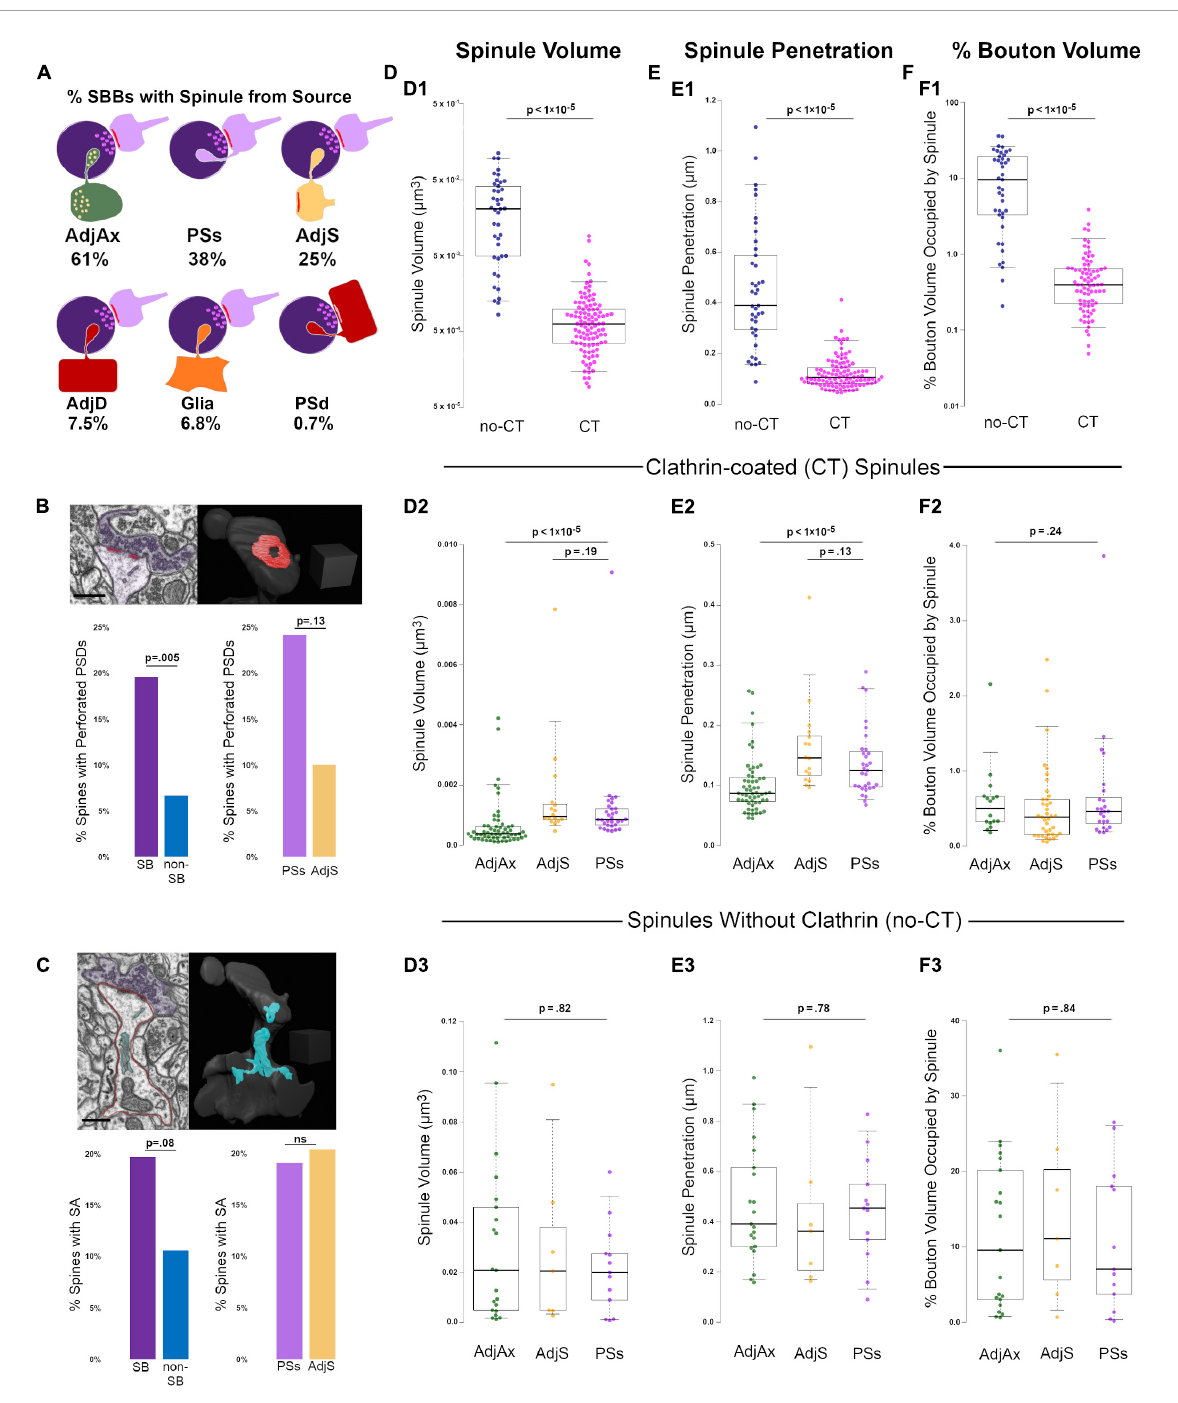
FIGURE2 Clathrin-coated (CT) and uncoated spinules (no-CT) are distinct populations within CA1 SBBs. (A) Cartoon showing the percentage of SBBs containing at least one spinule from adjacent axons/boutons (AdjAx), postsynaptic spines (PSs), adjacent (no synapse with SBB) spines (AdjS), adjacent dendrites (AdjD), glia, and postsynaptic dendrites (PSd). Percentages reflect the ∼ 42% of SBBs with spinules from multiple sources. (B) Percentage of perforated PSDs in postsynaptic spines in this image volume. Upper left panel shows a FIB-SEM image of a postsynaptic spine (pink) with a perforated PSD (red) and its presynaptic SBB partner (purple). Note the CT spinule projecting just to the right of the PSD. Upper right panel shows 3D reconstruction of spine and PSD from FIB-SEM image; note this is the same spine as shown in Figures 1G 2 ,G 3 . Lower left panel shows the percentages of spinule-bearing (SB) and non-spinule-bearing (non-SB) postsynaptic spines displaying perforated PSDs. Lower right panels show the percentages of spines projecting PSs spinules and AdjS spinules into SBBs that display perforated PSDs. (C) Percentage of spines with a spine apparatus in this image volume. Upper left shows a FIB-SEM image of the same postsynaptic spine (outlined in pink) as in panel (B) , displaying a spine apparatus (cyan), with a synapse onto an SBB (purple). Upper right panel shows the 3D reconstruction of this